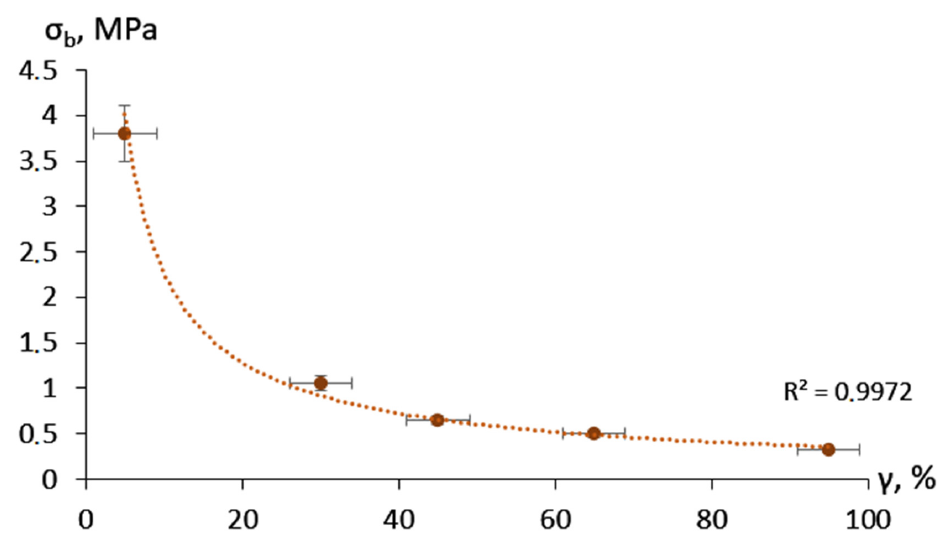
Figure 3. Adhesion bond strength depending on the moisture content.